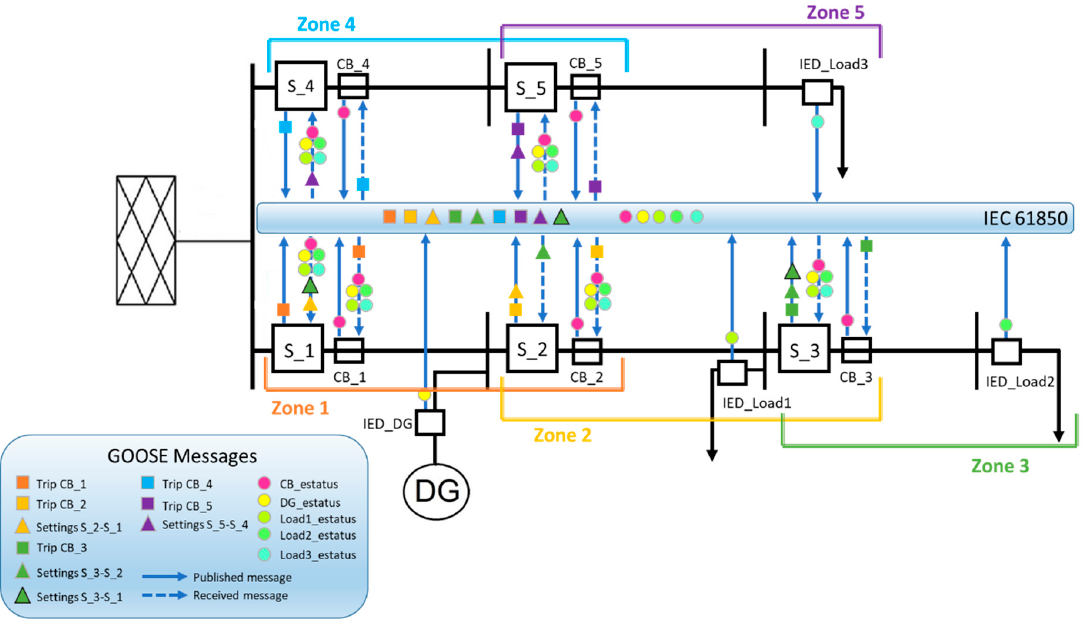
Figure 5 . APS exchange information: smart-sensor coordination. Figure 5. APS exchange information: smart-sensor